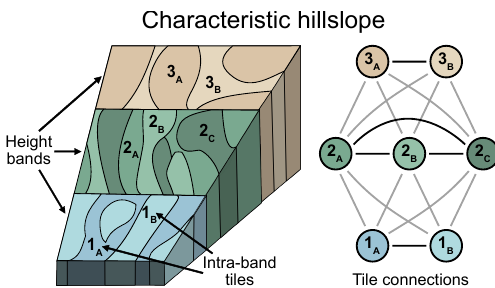
Figure 2. Schematic representation of a characteristic hillslope. Each characteristic hillslope is divided into height bands, which in turn are partitioned into intra-band tiles. Each tile interacts via the subsurface flow of water with the tiles in its same height band and with all the tiles in the height bands below and